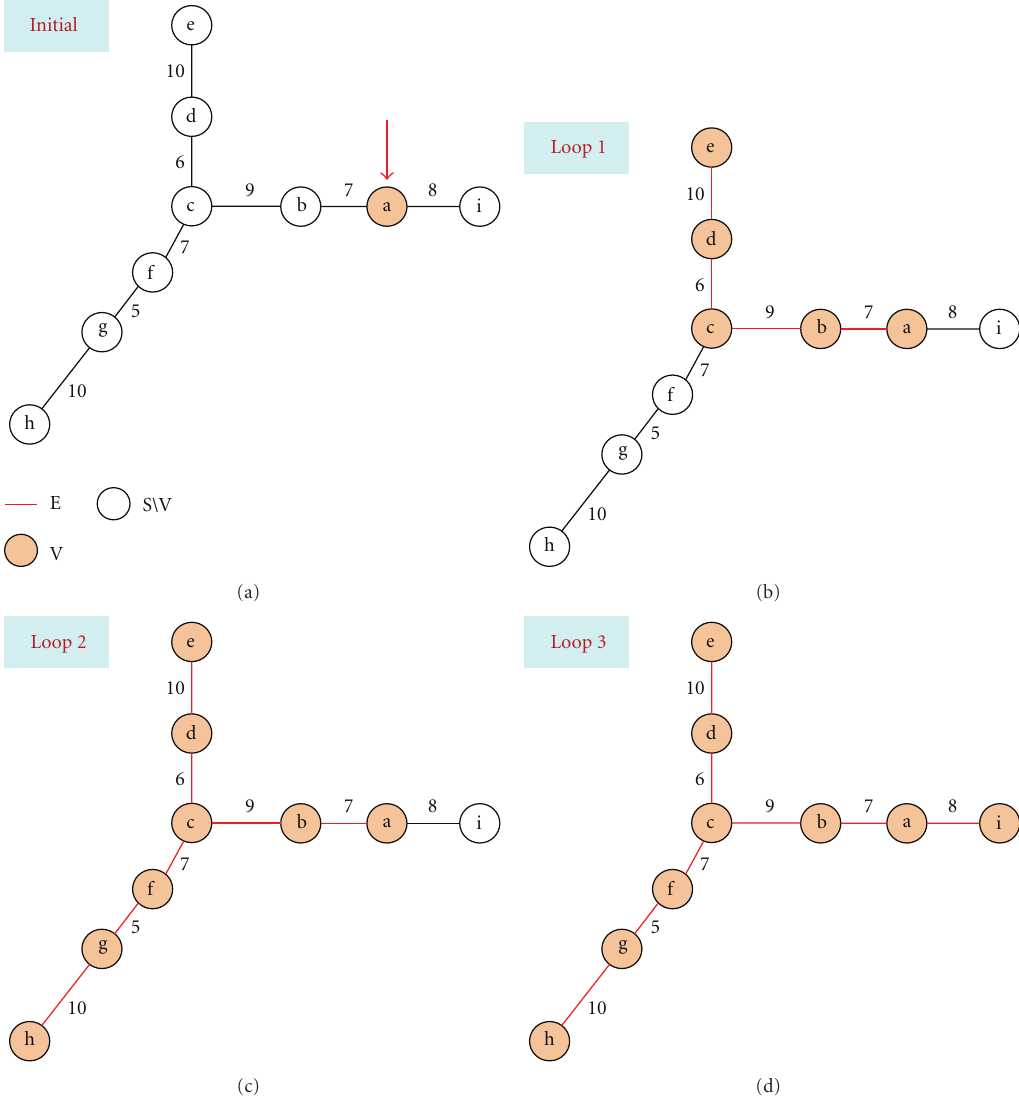
Figure 3: Illustration of the graph construction procedure. Each loop starts with Step 1 and ends at Step 4. In the graph, the nodes (i.e., “a”–“i”) denote the skeleton points, the edges between nodes represent the distance between the skeleton points. In this example, let “a” be the randomly selected point, then other skeleton points are added to the voxel set V in the following sequence: “bcde | fgh | i | ”, where “ | ” means Step 4 is